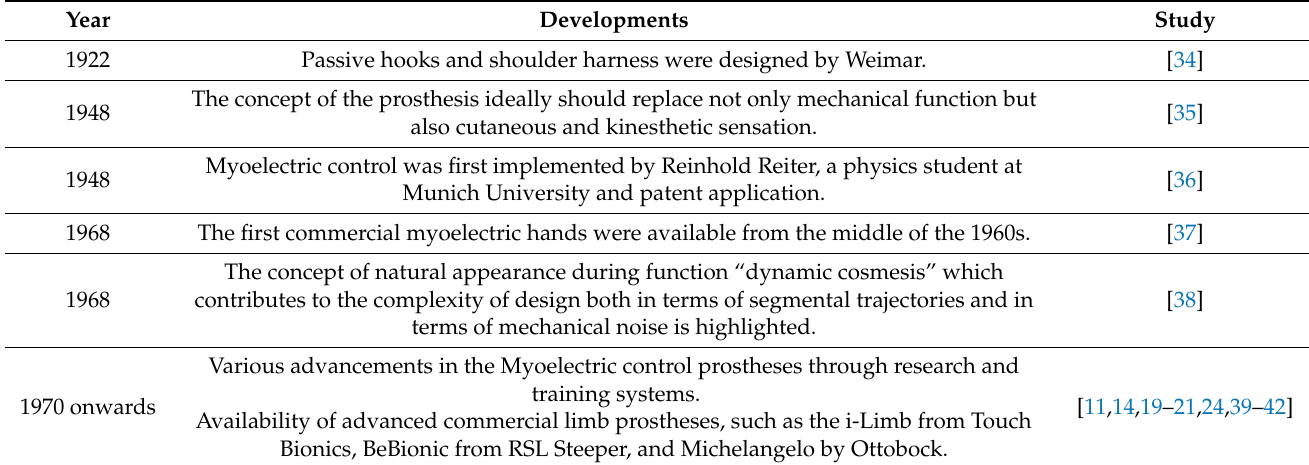
Table 1. Summary on the developments in myoelectric finger prostheses.